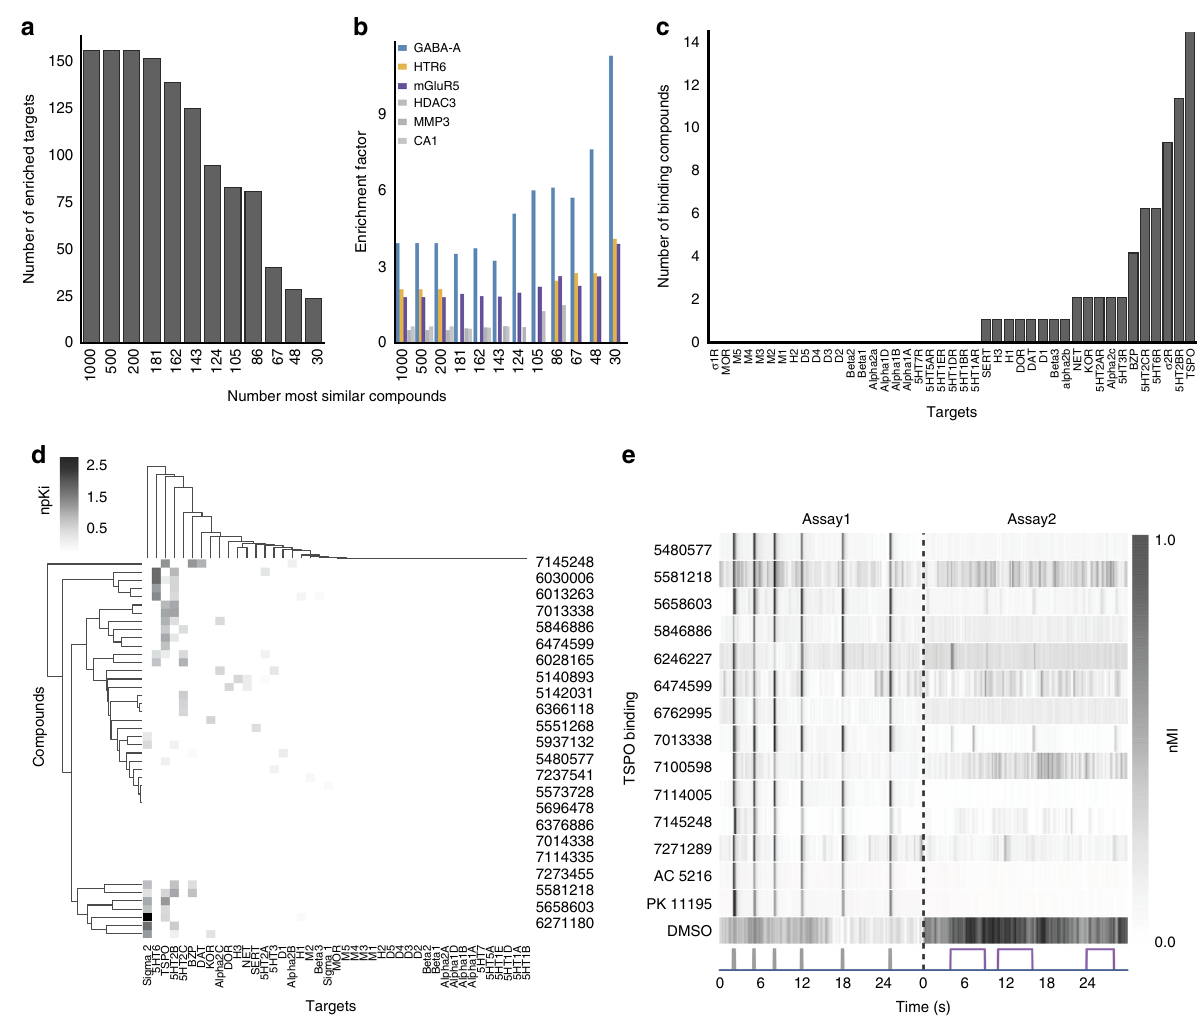
Fig. 3 Potential targets include GABA A R, mGluR, TSPO, and HTR6. a SEA analysis was performed on decreasing numbers of hit compounds (1000-30). The bar plot shows the number of SEA enriched targets decreasing as the analysis focuses on the top 30 hit compounds. b The bar plot shows increasing enrichment of GABA A R, HTR6, and mGluR5 as the top targets predicted for the top 30 hit compounds. c This bar plot shows the number of 46 primary hit compounds ( y -axis) that bound to the indicated CNS receptors ( x -axis). d The clustergram shows binding af fi nity pro fi les at the indicated CNS receptors. The colorbar indicates normalized Ki (npKI). e Heatmap of average motor activity pro fi les for TSPO binding compounds ( y -axis) over time ( x -axis) ( n = 12 wells). Assay 1 is comprised of 6 low-amplitude acoustic stimuli (gray); Assay 2 is a series of 3 violet light pulses (violet). These two assays are separated by a dotted line. AC 5216 and PK 11195 are TSPO binding compounds. Abbreviations: nMI, normalized motion index; MMP3, matrix metallopeptidase 3; CA1, carbonic anhydrase 1; HDAC3, histone deacetylase